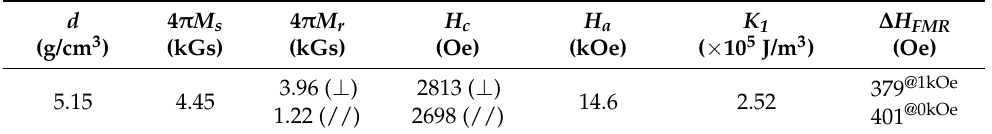
Table 1. Physical, magnetic, and gyromagnetic properties of textured barium hexaferrites. ⊥ and // denote the applied magnetic field perpendicular and parallel to hexagonal crystallographic c-axis.